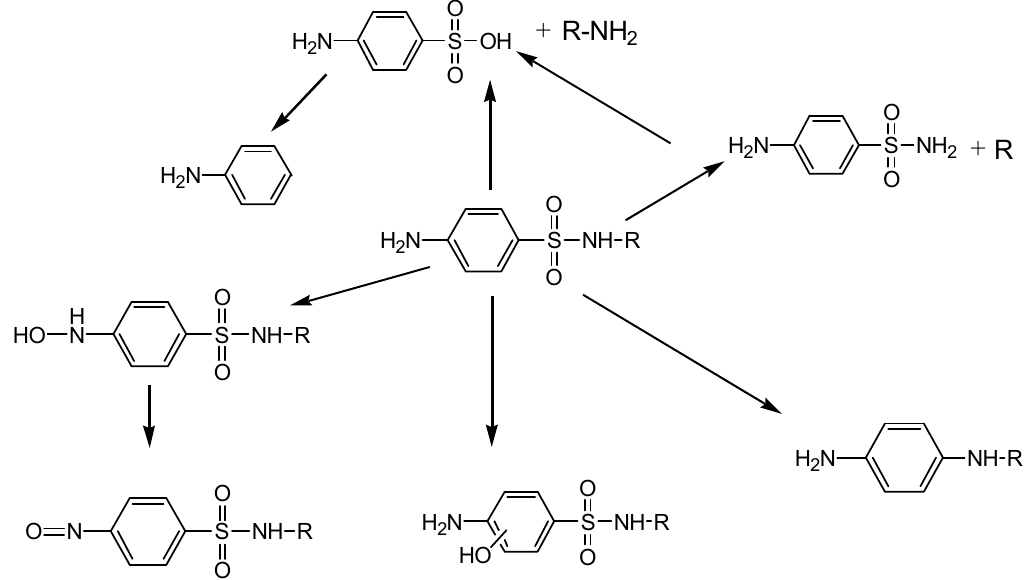
Figure 6. Proposed degradation pathways of sulfonamides during the UV/H 2 O 2 oxidation process (R represents a heterocyclic ring).